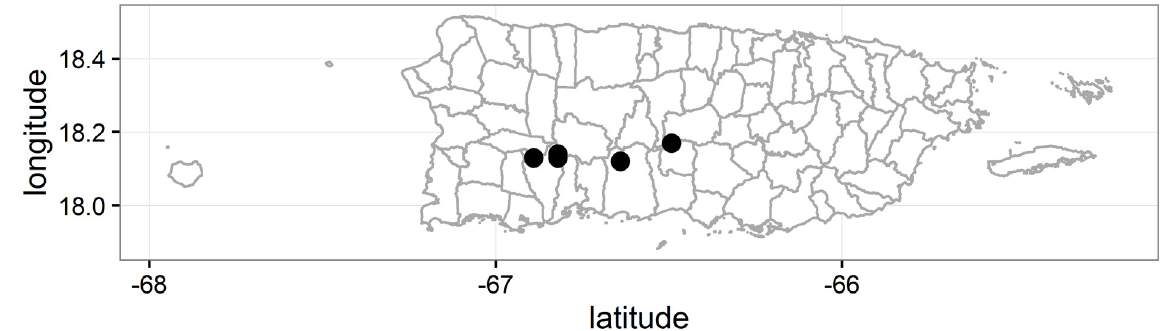
Fig. 20. Distribution map for Lasioglossum genaroi sp.